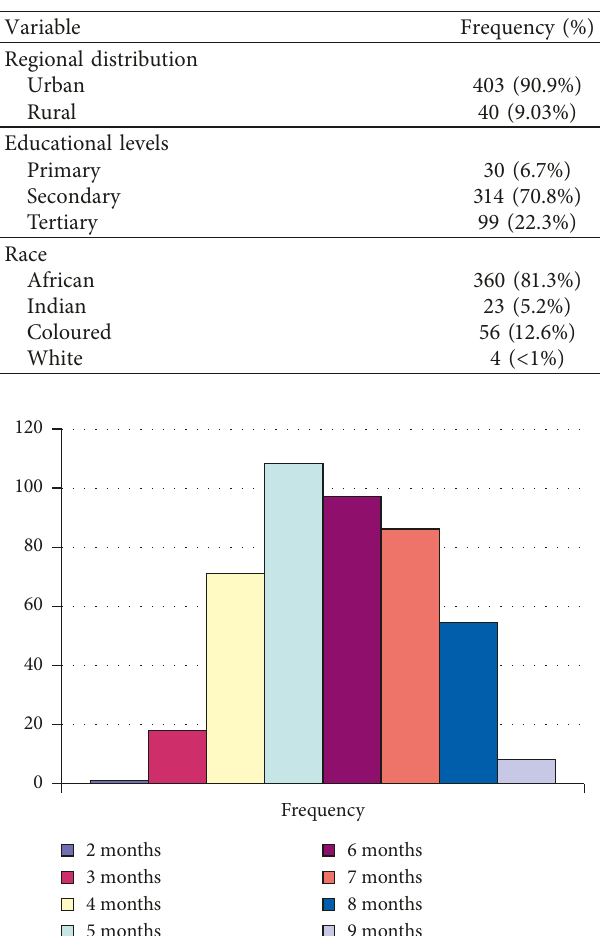
Table 1: Regional distribution, educational levels, and race of participants.